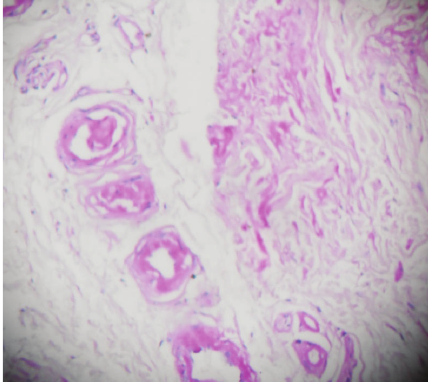
Figure 7: PAS staining showed positive